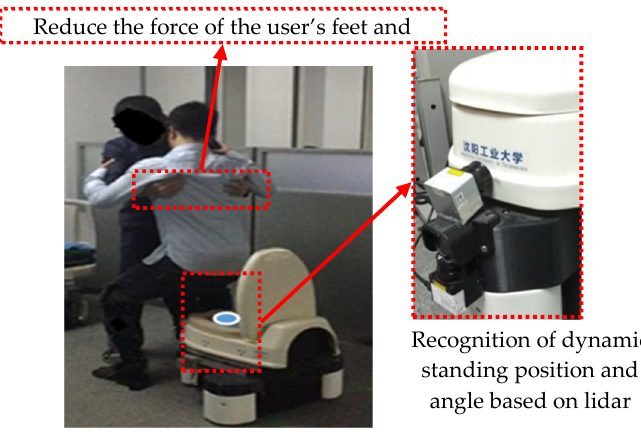
Figure 11. Optimization of the transfer process from the aspect of the multiple welfare-robots system and nursing staff.